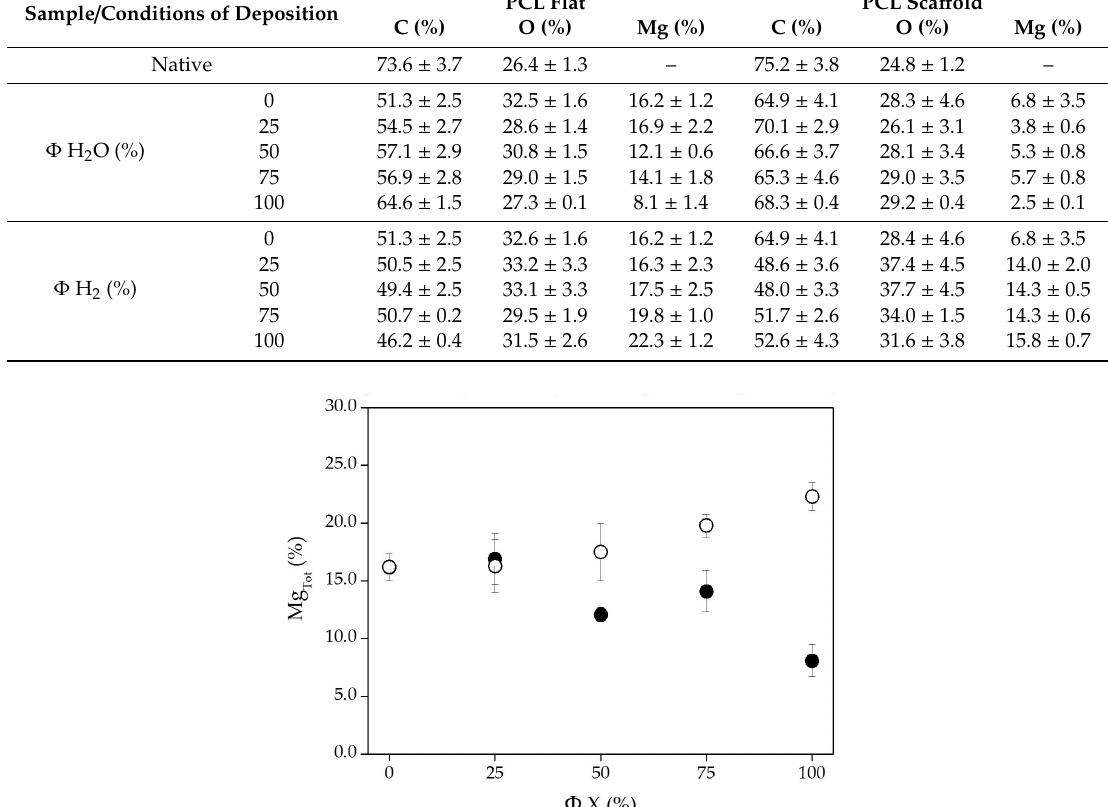
Figure 2. XPS surface magnesium percentage (Mg Tot %) of PCL flat samples as a function of the feed composition. Note: • = H 2 O; o = H 2 .